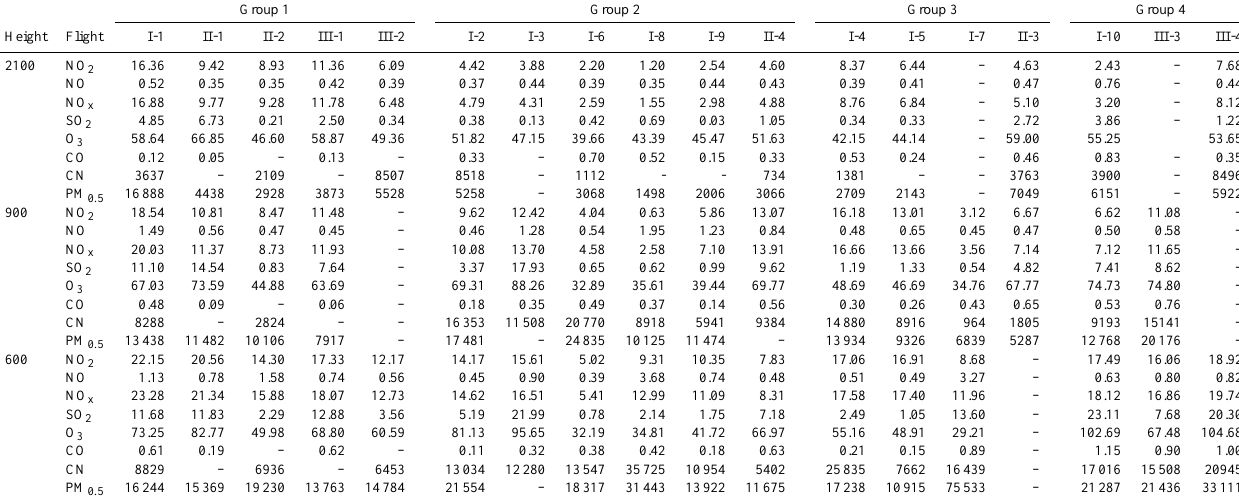
Table 2. The average concentration of gaseous pollutants and condensable nuclei concentrations at different heights for each flight. (The unit of CN, PM 0 . 5 are Ncm − 3 , CO is ppmV, and other gases are